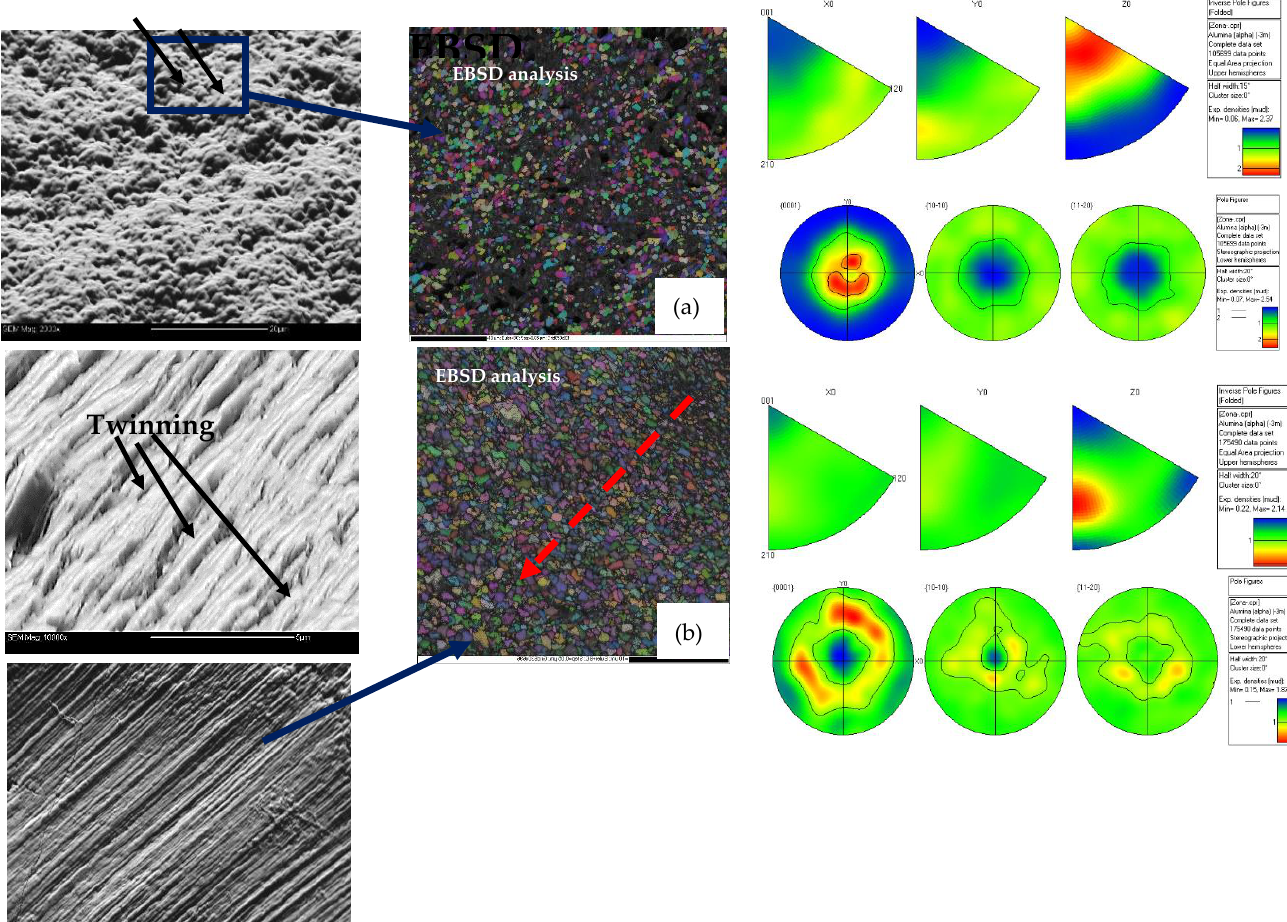
Figure 8. SEM and EBSD images of the coated tool surface during ( a ) initial state and ( b ) after wear.